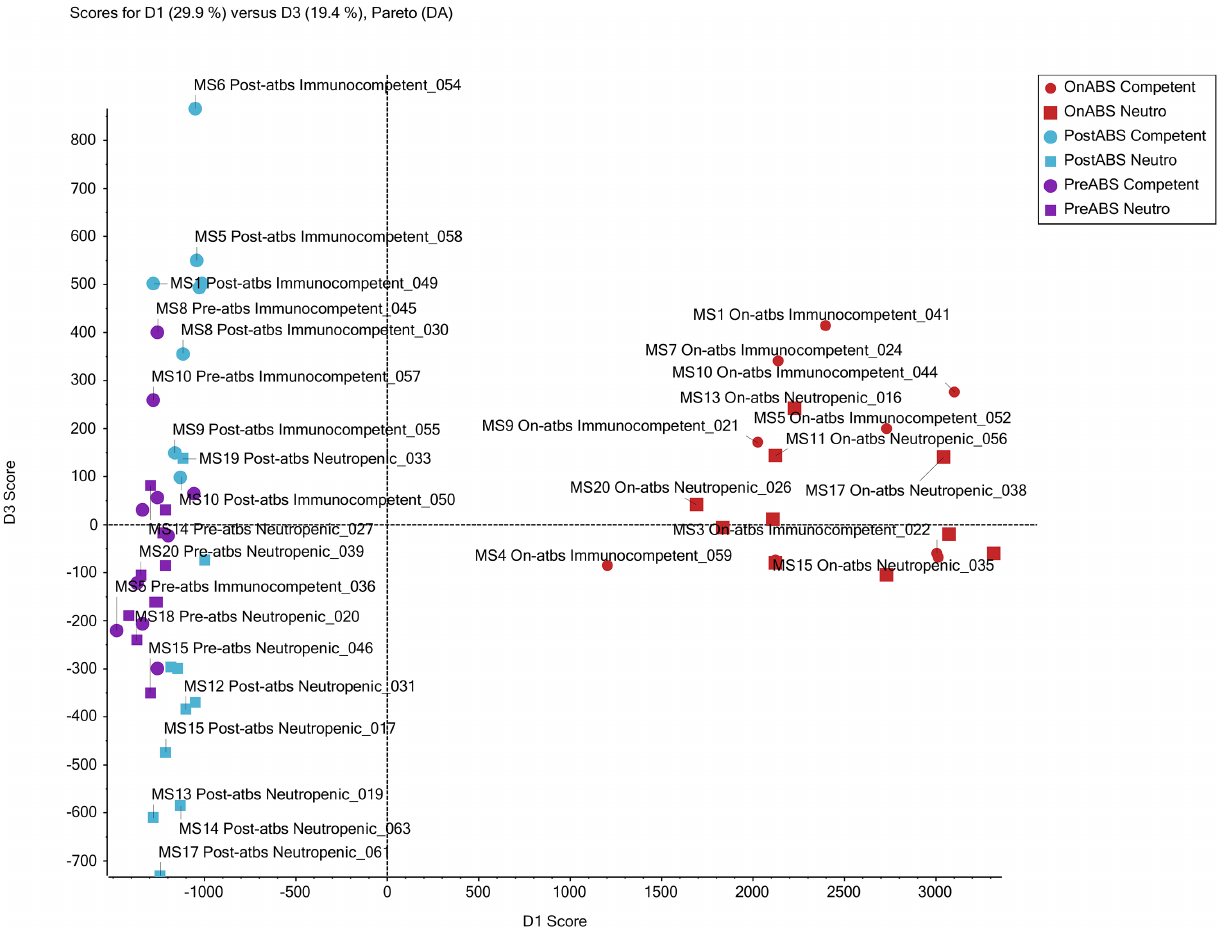
FIGURE 9 | Metabolomic profiling. Principal component analysis of non-targeted TripleTOF mass spectrometer (MS) data of mouse feces successfully grouped treatment from non-treatment mice. The scores plot for PC1 and PC3 of MS features in positive ion mode shows good separation of the antibiotic vs. non-antibiotic time points. Furthermore, clusters of post-antibiotic immunocompetent and post-antibiotic neutropenic features also show good separation from each other with immunocompetent clustering above and neutropenic below the x